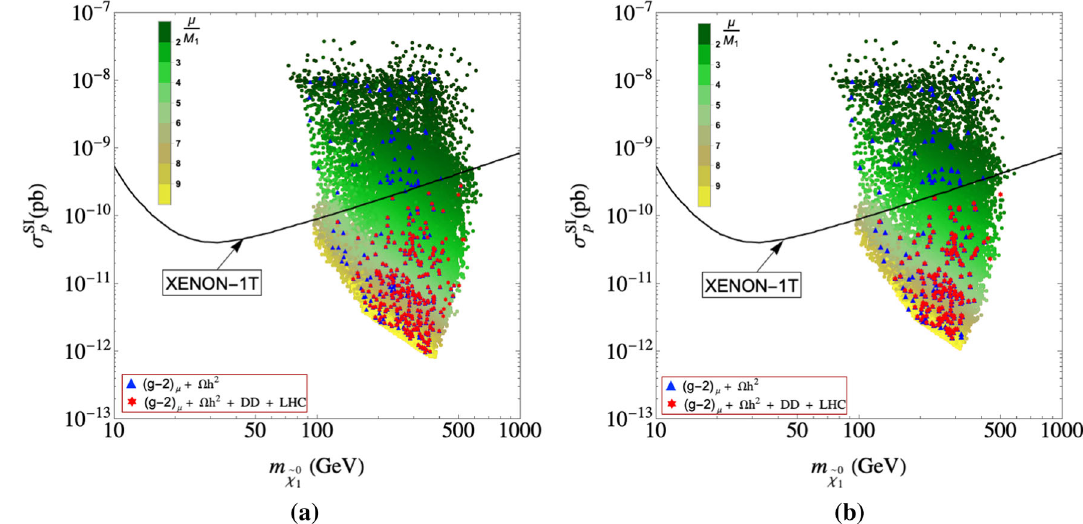
Fig. 8 The results of our parameter scan in the σ SI p − m ˜ χ 0 from ( g − 2 ) μ ). The color coding as in Fig. 4